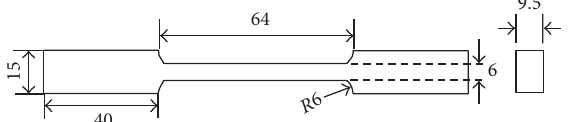
Figure 4: Tensile specimen dimensions (mm), following the norm ASTM-E8M.